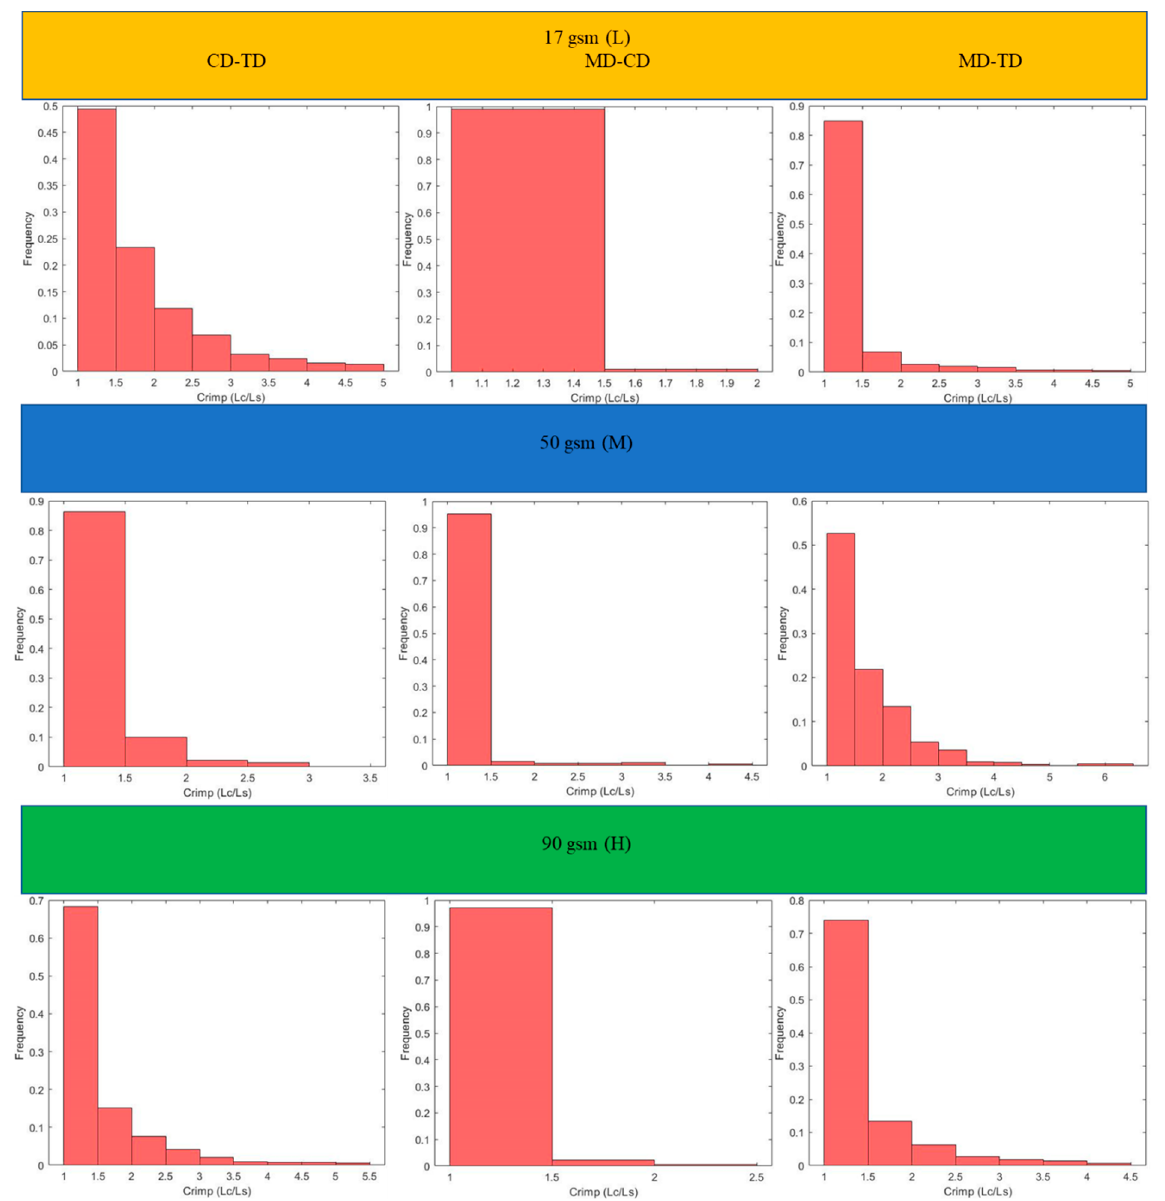
Figure 11. Two-dimensional crimp of crimped